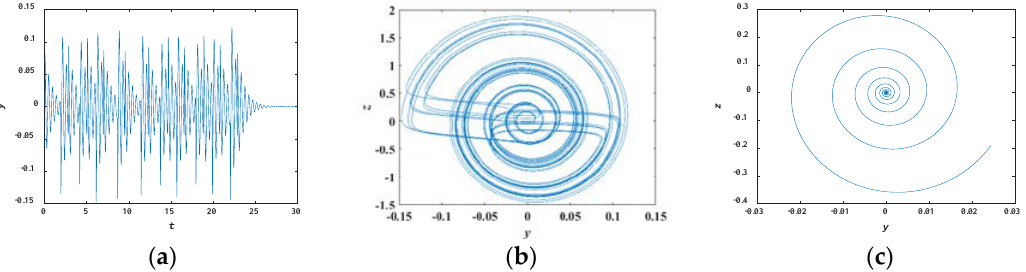
Figure 15. The transient phenomenon of the system: ( a ) the time-domain wave of the state y ; ( b ) the attractor with the time duration t = 0–23; ( c ) the attractor with the time duration t =